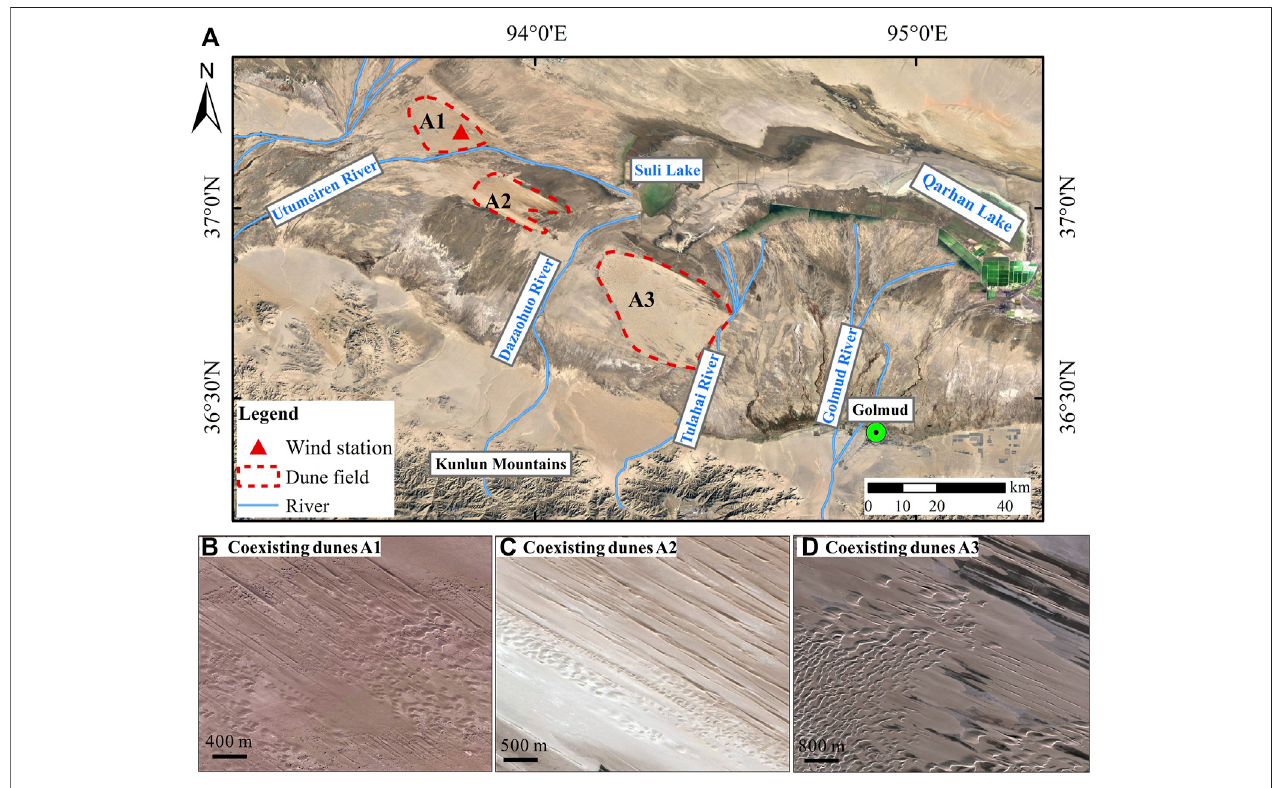
FIGURE1|(A) Locationofthestudyareaandwindsamplingstation; (B – D) imagesofareasA1,A2,andA3(respectively)wherebarchansandlineardunescoexist in the Qaidam Basin. Image source: Google Earth (https://earth.google.com/).